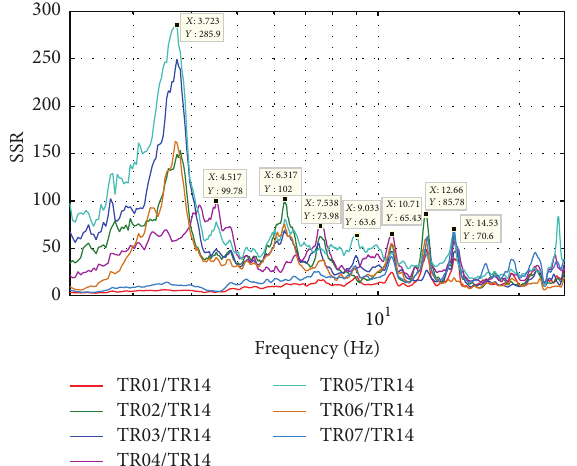
Figure 11: Radial spectral ratios derived for the left side of the dam.